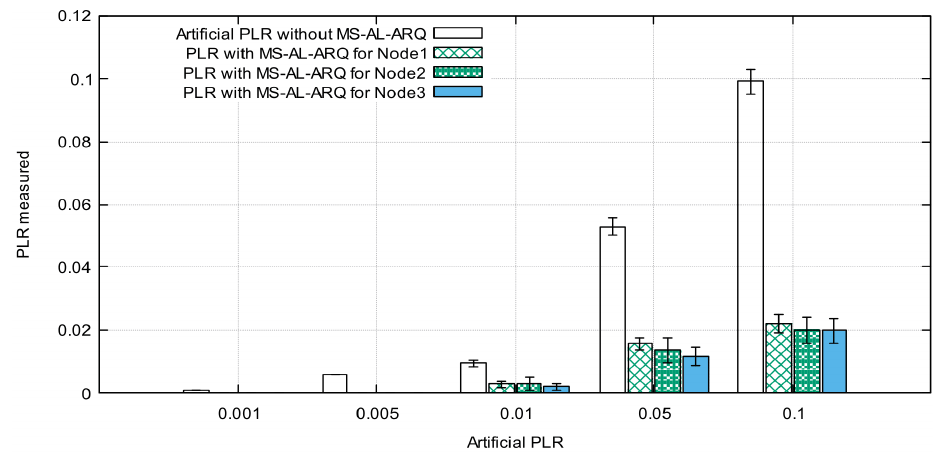
Figure 10. Average packet loss rate (PLR) for 3 nodes.